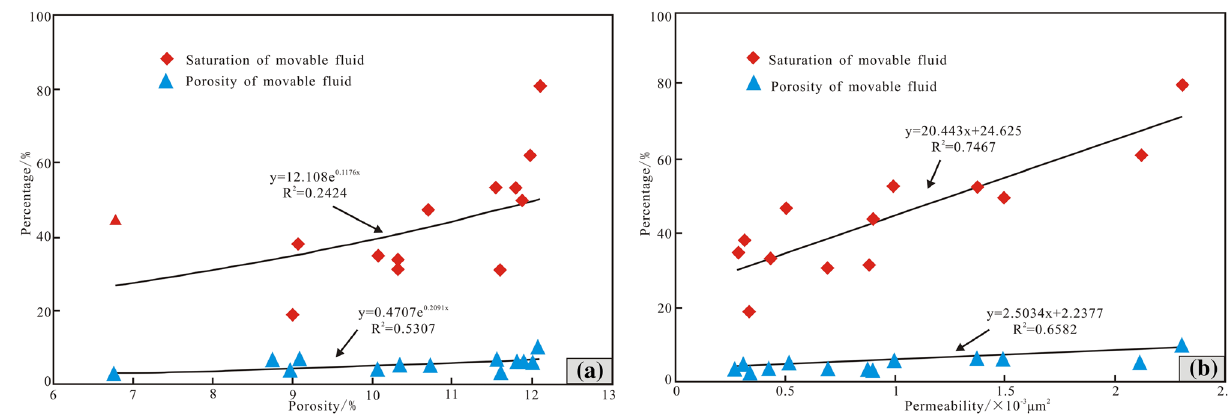
lution pores; c Well H56, 2484.52 m, illite; d Well L78, 2181.1 m, chlorite film; e Well L91, 2396.9 m, kaolinite filling; f Well